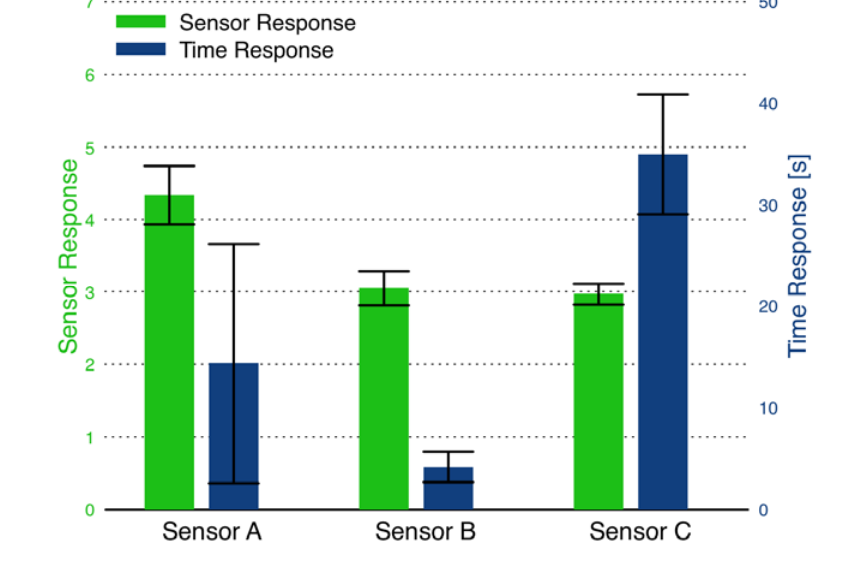
Figure 7. Comparison of sensor response and time response for sensors fabricated using the three binder recipes. Sensor A: hydroxypropyl cellulose-based binder, Sensor B: ethyl cellulose-based binder, and Sensor C: silicate-based binder. The error bars represent the standard deviations for each sensor.